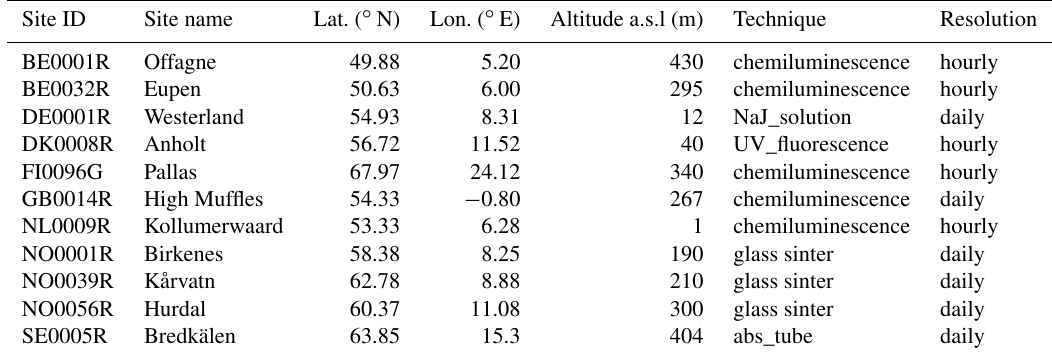
Table 1. Surface NO 2 measurements over Europe during 1 December 2009–31 January